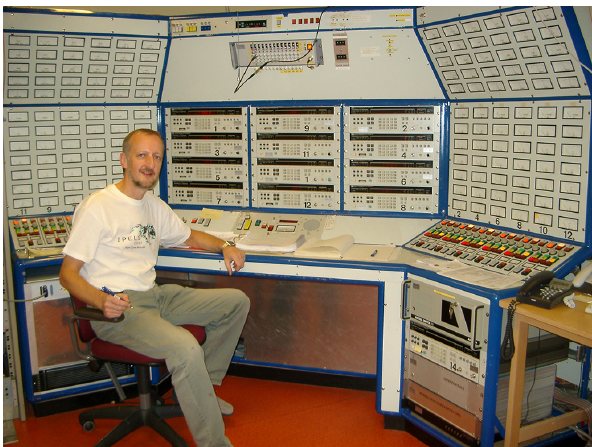
Figure 6. The Heating facility console in the control room as it was in 2007, with the first author at the controls. Six columns of meters, lights, and push buttons on each side show the status and are used to control each of the 12 transmitters. The 12 commercial RF syn- thesizers in the middle of the console have been replaced by digital synthesizers in the transmitter hall, and the space is now filled with large computer screens. (Photo credit: Michael T.